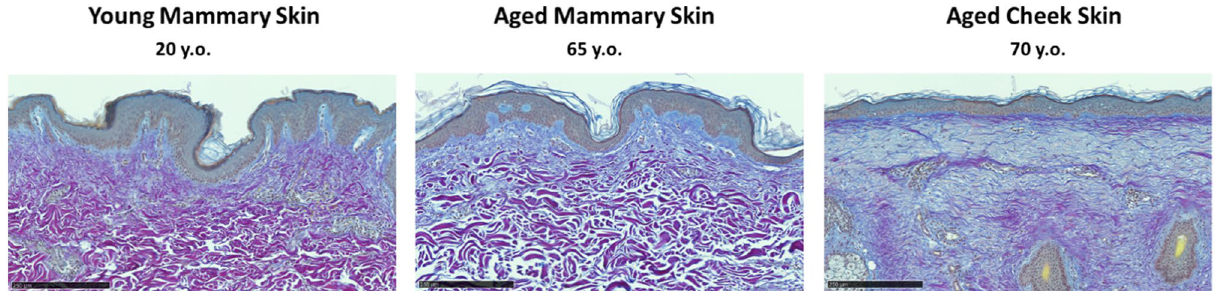
Figure 6. Herovici stains of young mammary skin (left), aged mammary skin (middle) and aged cheek skin (right). Purple collagen is considered intact, while collagen stained blue is degraded. Scale bar is 250